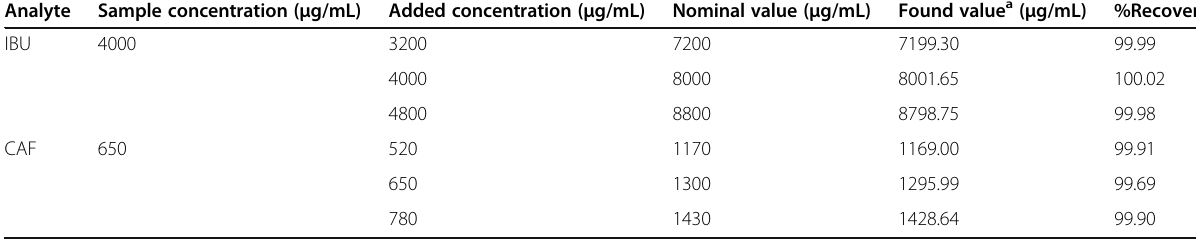
Table 4 Specificity for the determination of IBU and CAF by the standard edition method